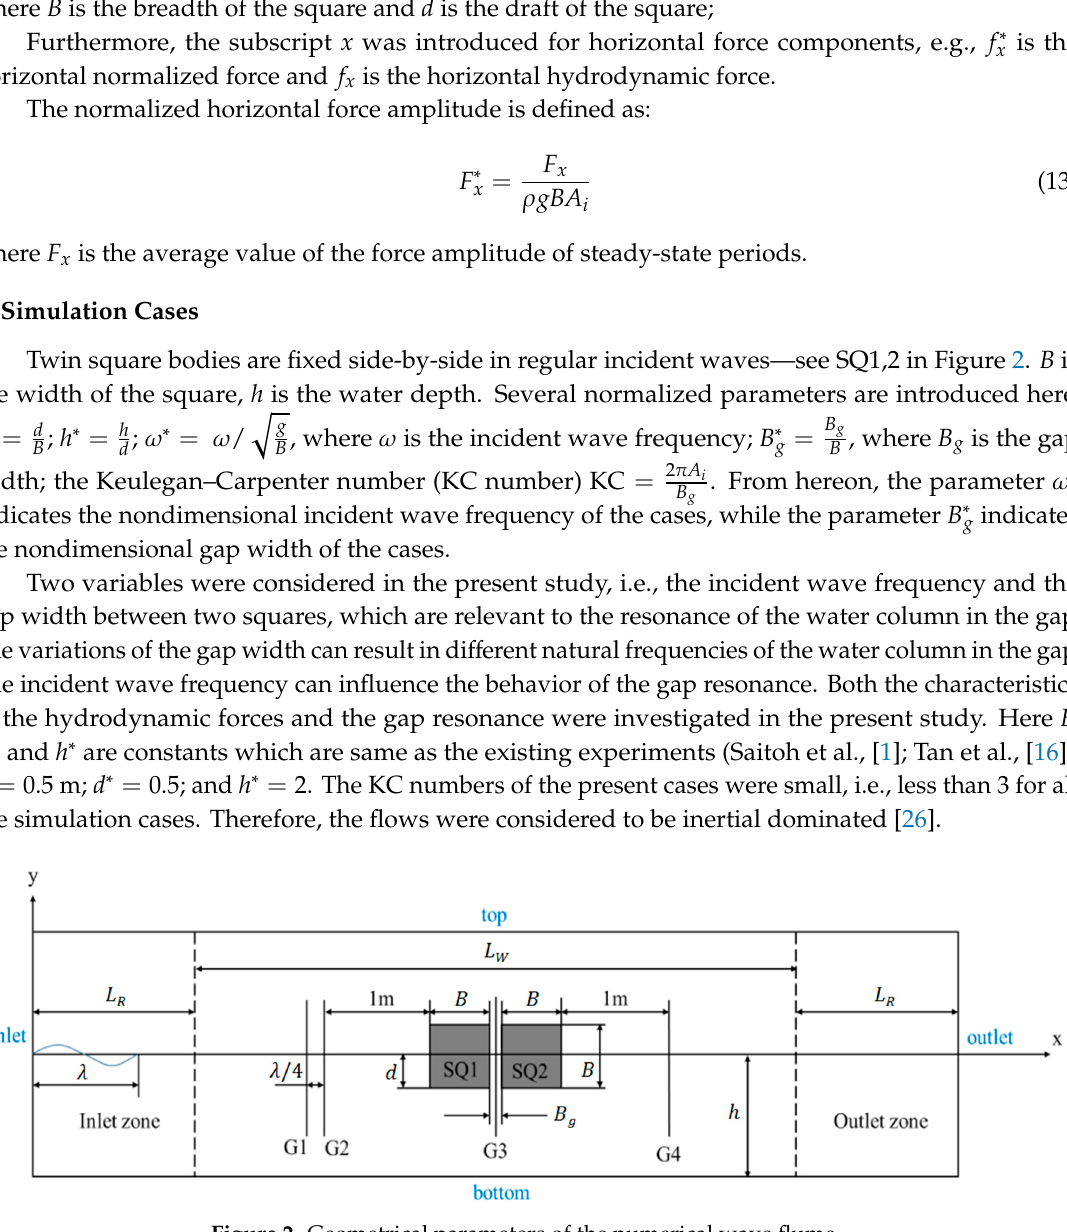
Figure 2. Geometrical parameters of the numerical wave flume.